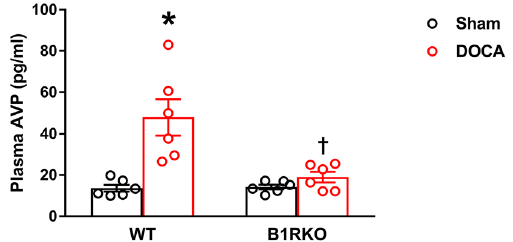
Figure 4. Plasma arginine vasopressin (AVP) expression in DOCA-salt hypertension. Three weeks of DOCA- salt treatment significantly increased plasma AVP levels in wild-type (WT) mice. This DOCA-salt-induced increase in plasma AVP was prevented in kinin B1 receptor knockout (B1RKO) mice with DOCA-salt treatment. Statistical significance: Two-way ANOVA followed by Tukey’s multiple comparisons test. * p < 0.05 versus WT + Sham; †, p < 0.05 versus WT + DOCA; n = 6/group.